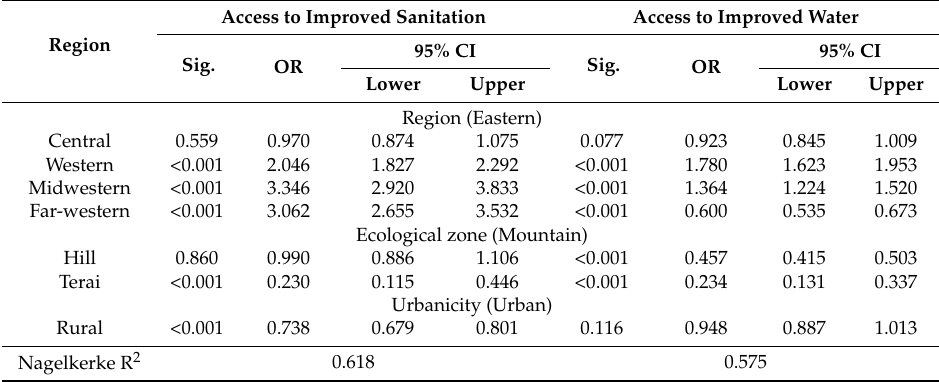
Table 3. Predictors of lacking access to improved sanitation and water in Nepal.